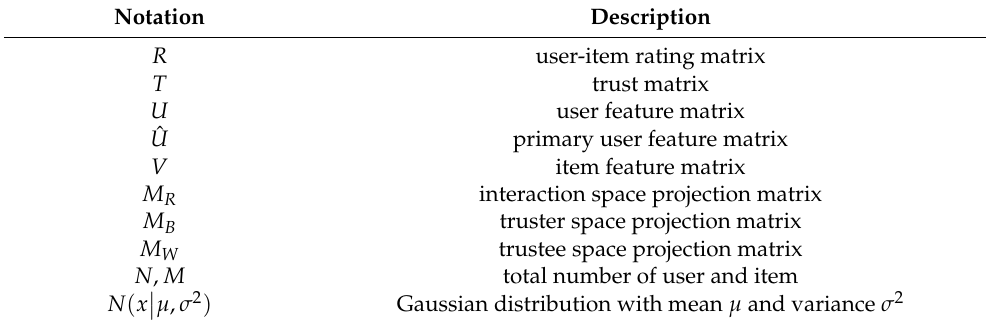
Table 1. Explanation of